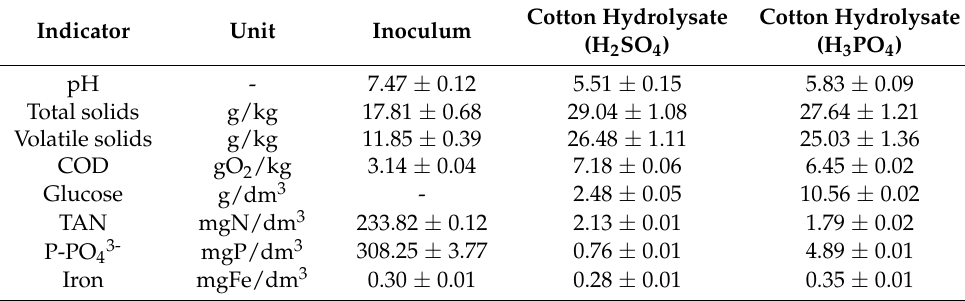
Table 3. Characteristics of undiluted substrates used for batch tests.